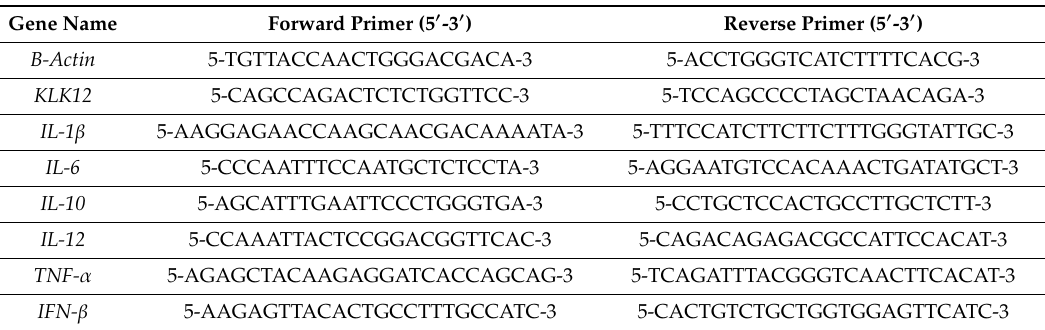
Table 1. Primers used in the present